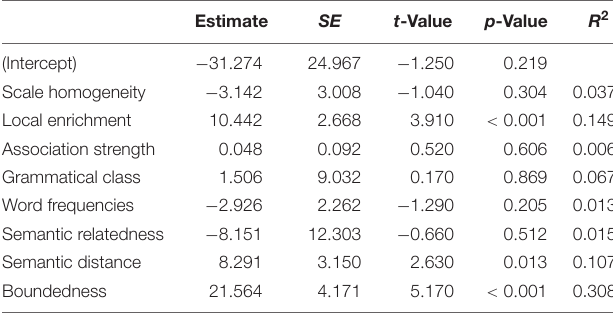
overlapped with the variance accounted for by semantic distance. TABLE 2 | Results of combined